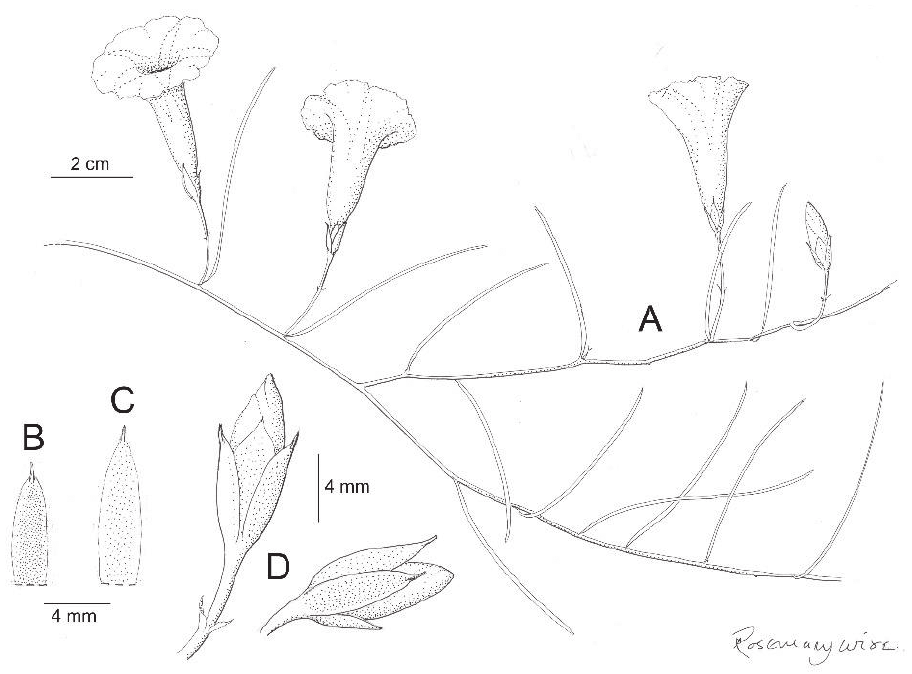
Figure 11. Ipomoea graminifolia. A habit B outer sepal C inner sepal D buds showing calyx. Drawn by Rosemary Wise from C. Munhoz et al.